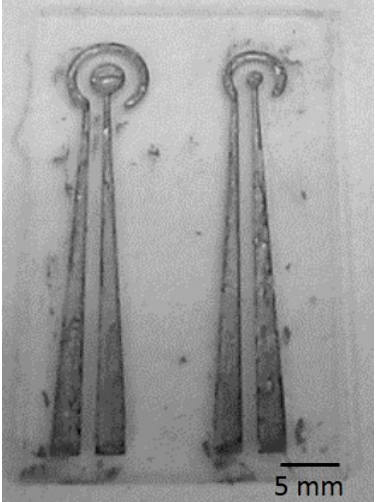
Figure 4. Photograph of the flexible electrodes.